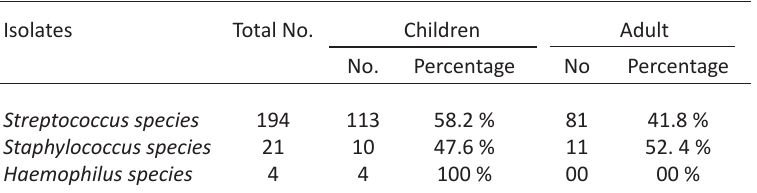
Table 2. Frequency of organisms isolated according to the age. Isolates